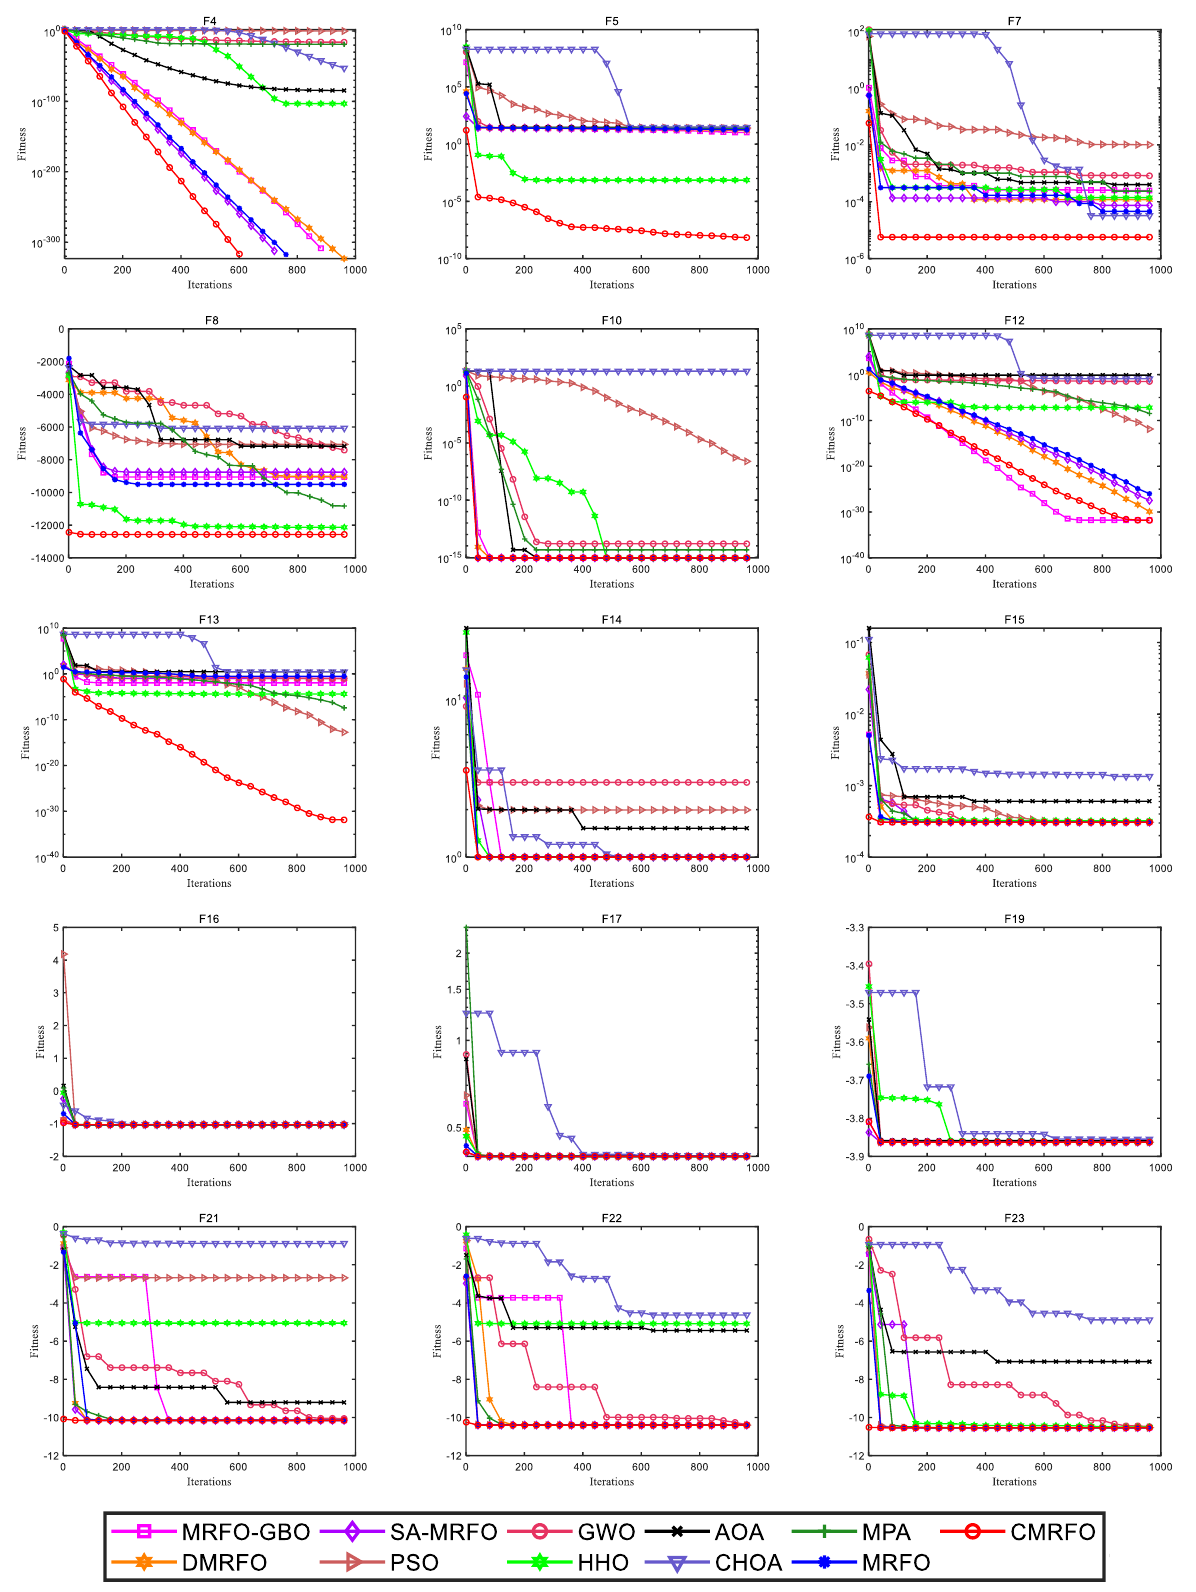
Figure 4. Convergence curves of 11 algorithms.